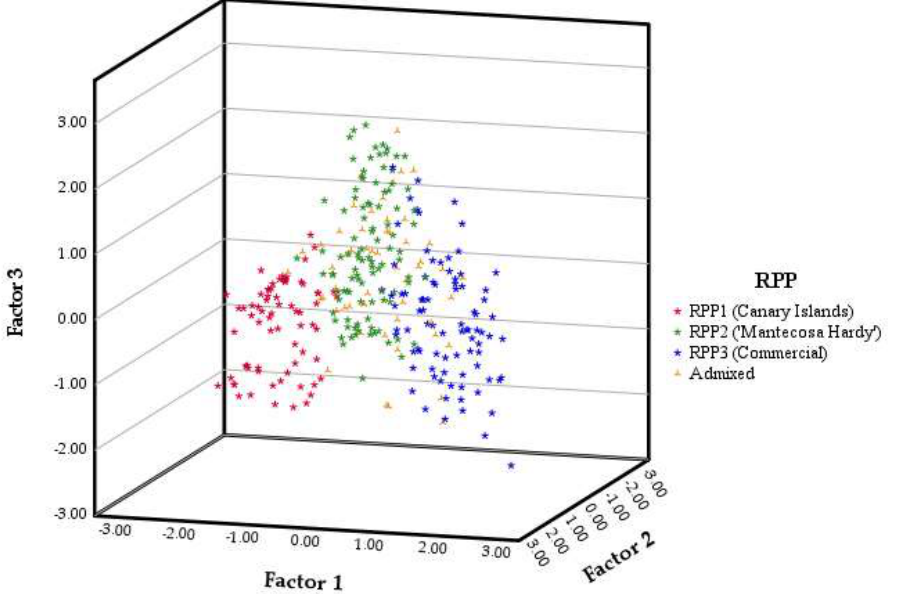
Figure 4. Representation of principal components (PCs) of reconstructed panmictic populations (RPP1 to RPP3) obtained with STRUCTURE using 18 SSRs and 310 pear genotypes. Genotypes with JC ≤ 0.13 (mostly from the RPP2 group) were the most differentiated by the PCoA in the positive Factor 2 (Figure 5) due to specific alleles that grouped genotypes. The allele with the highest coefficient (0.89) was 130 of the CHVF1 locus, present in Pyrus pyrifolia , P. calleryana , P. salicifolia , wild genotypes, seven Galician nursery varieties, five Asturian, many Galician and 26 genotypes from the Canary Islands (six from RPP1, 10 from RPP2, seven from RPP3 and three admixed); on the other hand, the negative coefficient was 245 for CH02c09 (−0.134), not present in P. pyrifolia or P. calleryana .